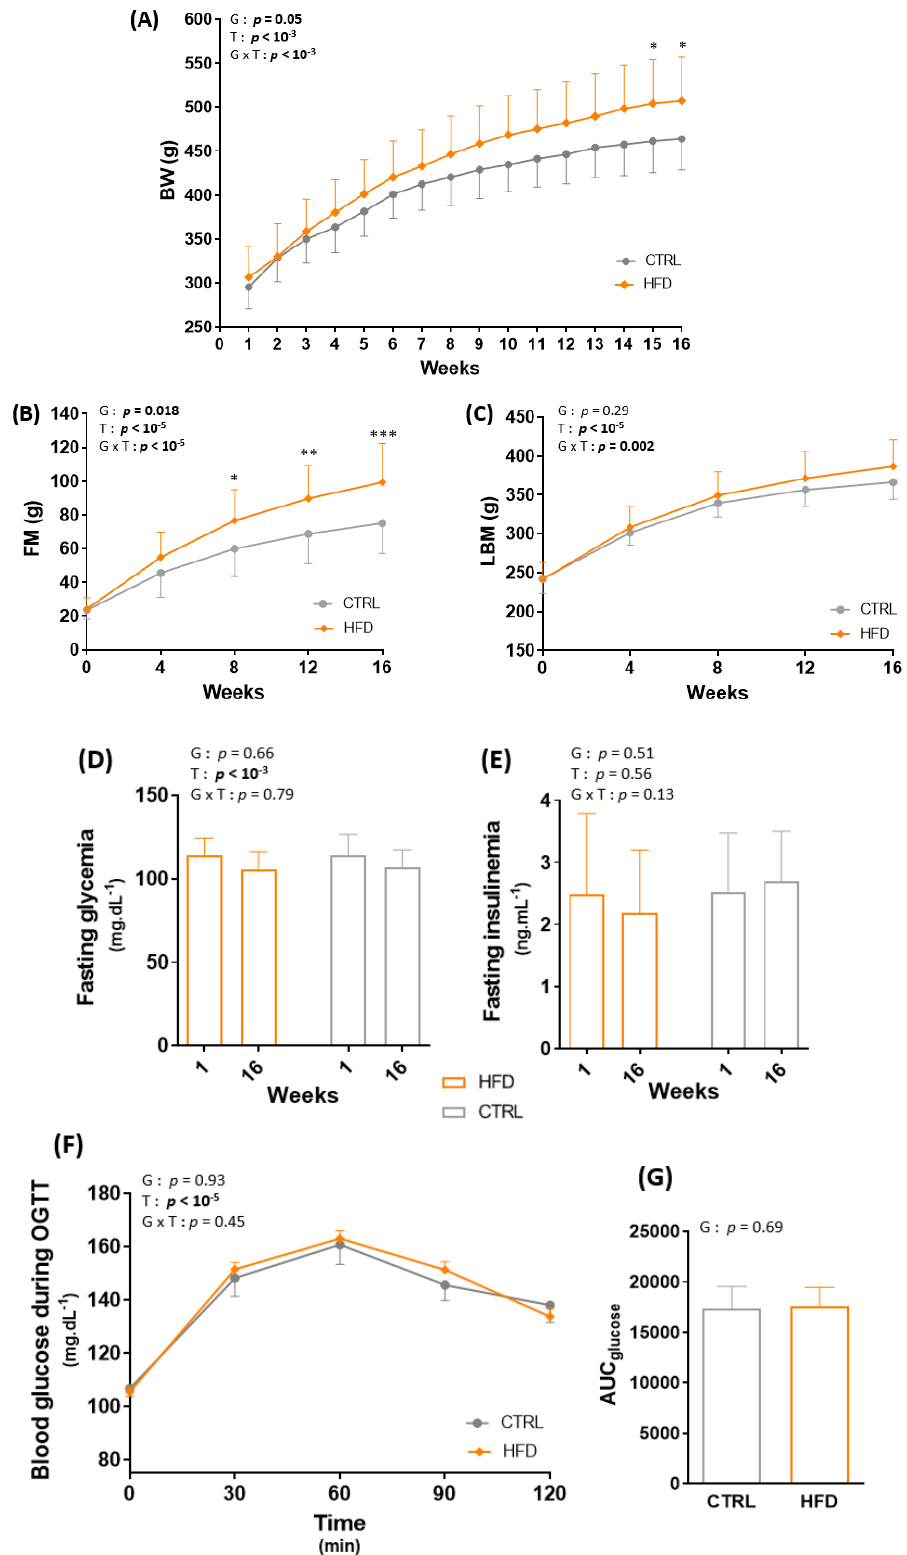
Figure 2. Effect of obesity induction on body weight (BW) ( A ), total fat mass (FM) ( B ), total lean body mass (LBM) ( C ), fasting glycemia ( D ), fasting insulinemia ( E ), blood glucose during the oral glucose tolerance test (OGTT) ( F ) and total area under the curve of glucose (AUC glucose ) ( G ). * p < 0.05, ** p < 0.005, *** p < 0.0005, G: group effect, T: time effect, G × T: group × time effect. CTRL: control group, HFD: high-fat diet.